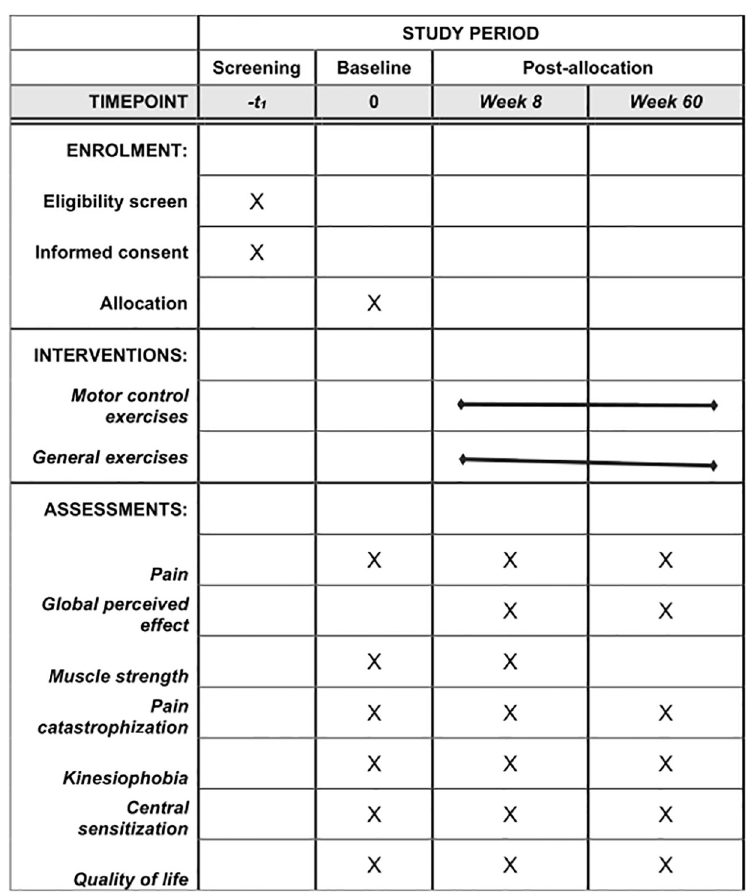
Fig 1. Schedule of the study protocol according to the standard protocol items: Recommendations for interventional trials checklist.